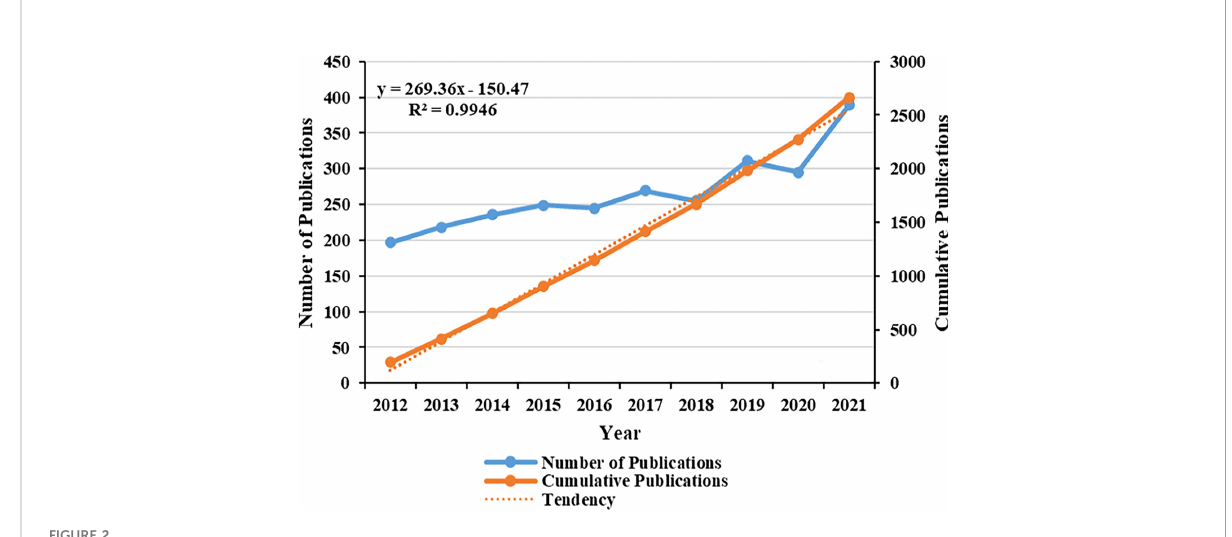
FIGURE 2 Annual and cumulative publications.